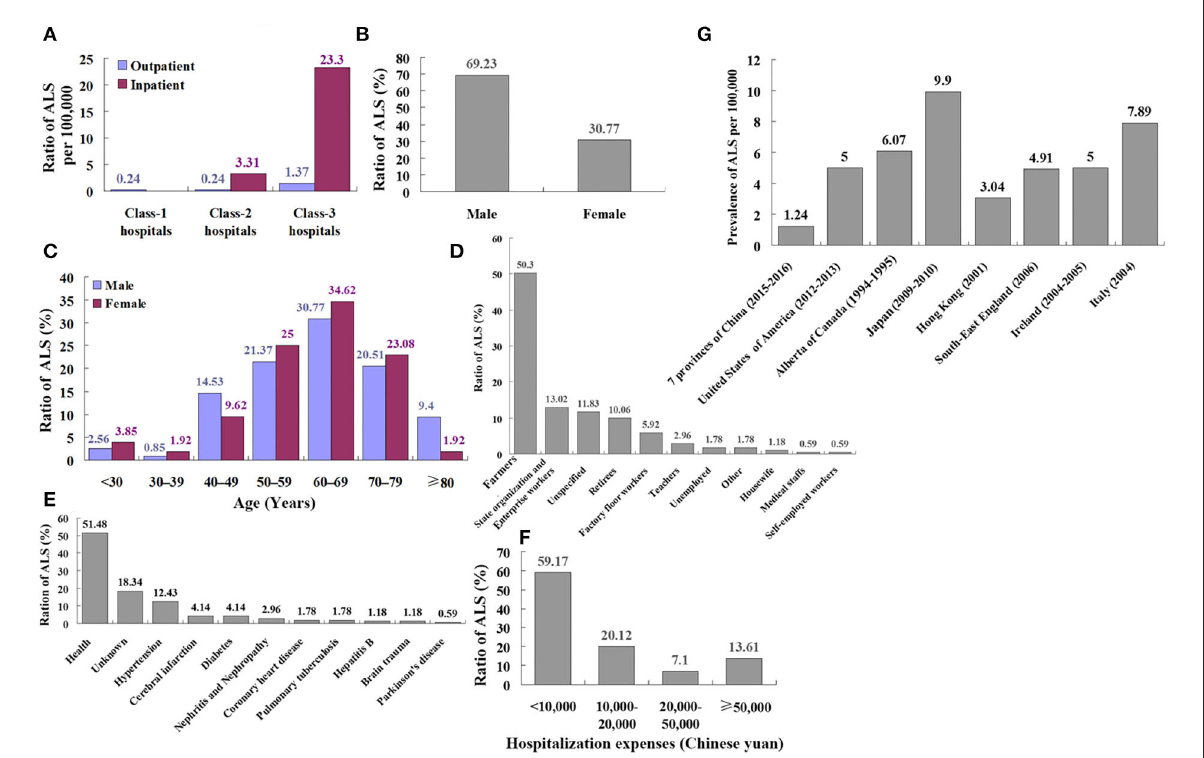
FIGURE3 The comparison of survey data based on the hospital. (A) The comparison of ALS ratio between outpatients and inpatients in the different level hospitals of China involved 13 class-3 general hospitals, 13 class-2 general hospitals, and 26 street health centers or community health service centers in urban districts, and 13 county-level general hospitals, 39 township health centers and 78 village clinics in rural districts. The prevalence of ALS in inpatients was higher than that in outpatients. The total prevalence of ALS in class-3 hospital patients showed the highest. (B) The gender ratio of patients with ALS in the hospital survey, among 169 patients with ALS in the hospital survey, 117 (69.23%) patients with ALS were male and 52 (30.77%) were female. (C) The onset age ratio of patients with ALS in the hospital survey, and among those 169 patients, the percentage of 60 to 69 years was the highest, and the percentage of 30 to 39 years was the lowest. (D) The profession ratio of patients with ALS in the hospital survey, and among 169 patients with ALS in the hospital survey, farmers were the highest percentage (50.3%), and both medical staffs and self-employed workers were the lowest percentages (0.59%). (E) The medical history ratio of patients with ALS in hospital survey, and among 169 patients with ALS in the hospital survey, most patients with ALS had no chronic disease history (51.48%). (F) The hospitalization expenses ratio of patients with ALS in the hospital survey, and among 169 patients with ALS in the hospital survey, the hospitalization expenses of most patients with ALS (59.17%) were lower than 10,000 Chinese Yuan. (G) The comparison of ALS prevalence in different countries. Our results showed that the prevalence of ALS in seven provinces of the Chinese mainland was 1.24/100,000, which was less than the world other nations and districts including Chinese Hong Kong and similar to the European per year prevalence (2.2/100,000) and United States